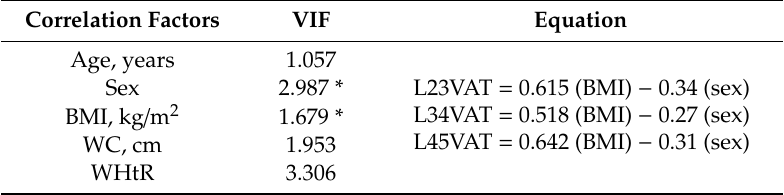
Table 7. Ethnicity-specific equations to estimate VAT depositions for M¯aori /